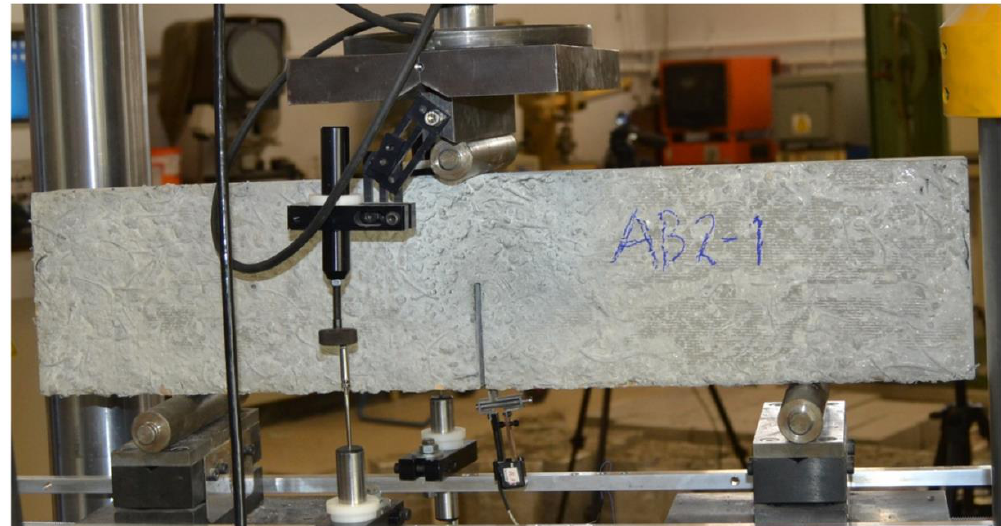
Figure 5. Beam specimen ready for testing.